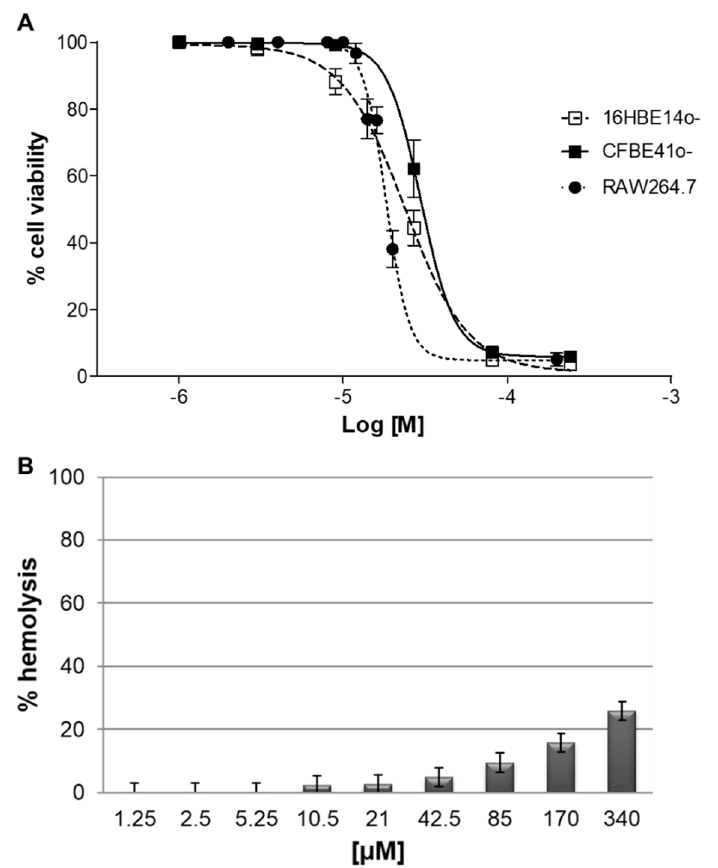
Figure 6. Cytotoxic and hemolytic effect of SET-M33D in vitro. RAW 264.7, 16HBE14o-, and CFBE41o- cells ( A ) were incubated with increasing concentrations of SET-M33D for 48 h. Cell viability is expressed as a percentage with respect to untreated cells ± SD. The experiment was performed twice in triplicate; n = 6. ( B ) Hemolytic activity of SET-M33D is reported as a percentage ± SD of red blood cell hemolysis after incubation for 24 h at 37 °C.